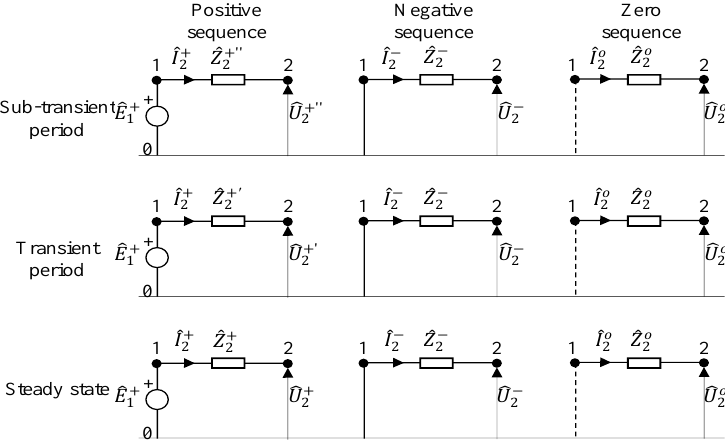
Figure 2. Synchronous machine models for fault calculations.